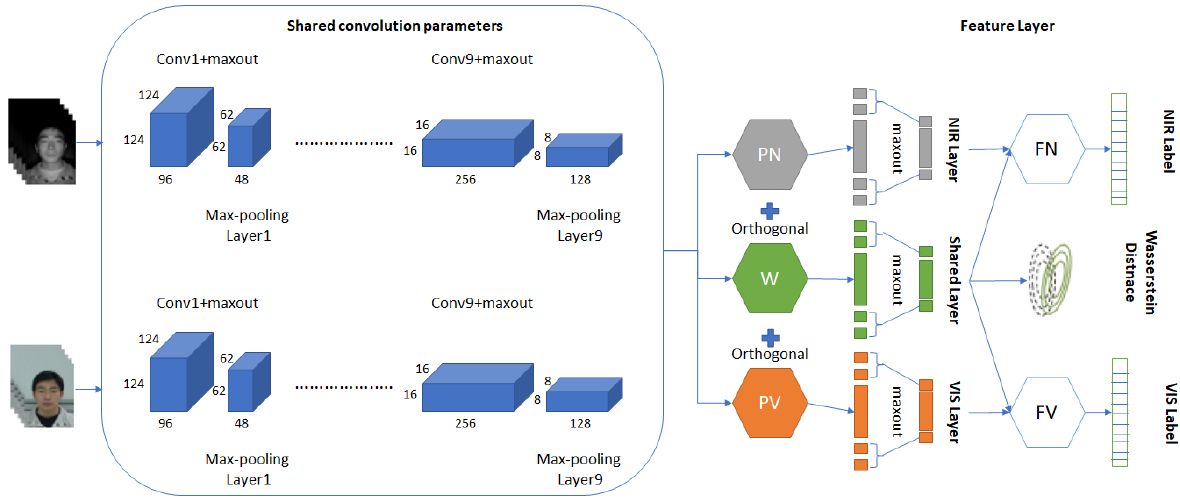
Figure 13. An illustration of the proposed Wasserstein CNN architecture in